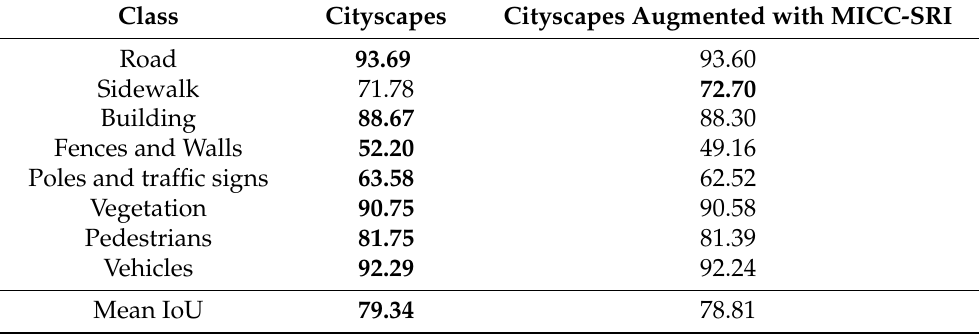
Table 4. Semantic segmentation (IoU) with Xception on Cityscapes dataset and Cityscapes dataset augmented with MICC-SRI